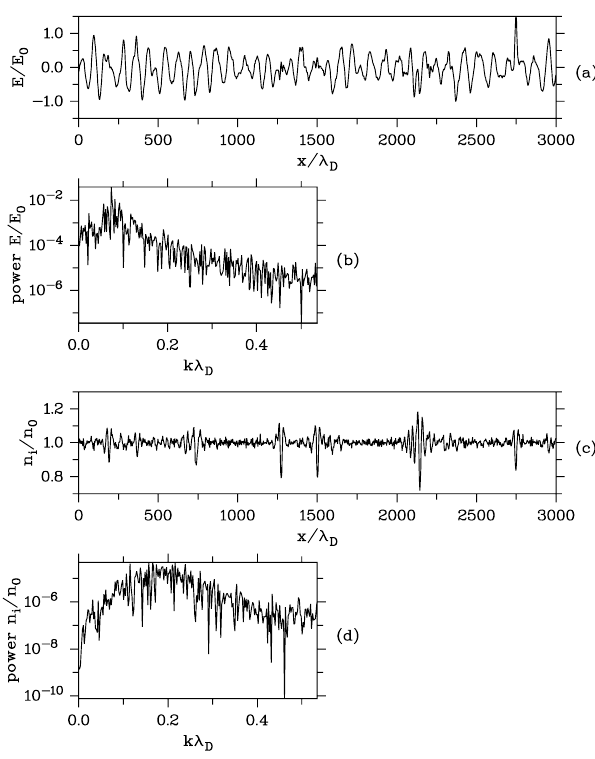
Figure 1. Spatial profiles of field (a) , proton density (c) and as- sociated power spectra (b) , (d) at an early time t = 200 ω − 1 pe of the beam–plasma evolution. The almost coherent field structure is dominated by the wave number kλ D ≈ 0 . 075 of the fastest growing mode. Beam velocity V b = 16 v the , beam density n b = 0 . 0057 n 0 .